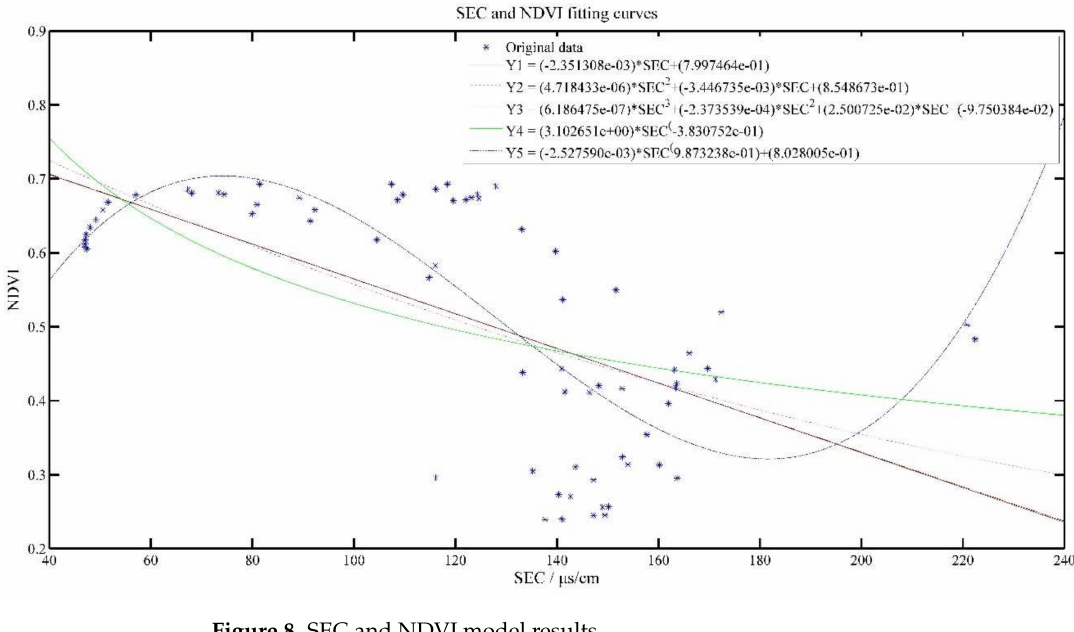
Figure 8. SEC and NDVI model results.